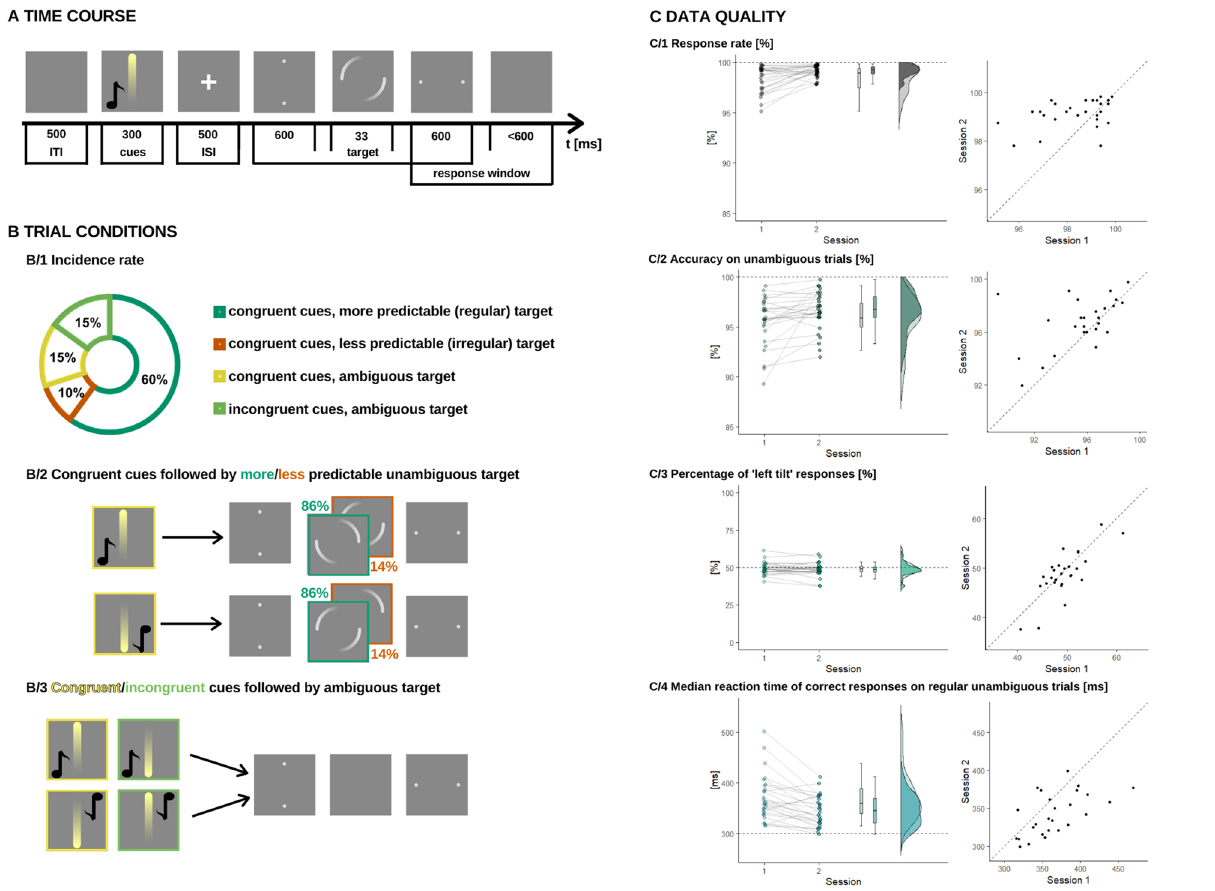
Figure 1. Experimental paradigm and data quality. ( A ) Time course. At the beginning of every trial, a multimodal cue pair was presented for 300 ms consisting of a yellow dot moving up or down and a higher or lower tone. This was followed by a 500 ms interstimulus interval, during which a fixation cross attracted attention to the middle of the screen. Then we presented dot pairs in vertical, then in horizontal position for 600–600 ms. Between these for 33 ms a motion strike indicated a turning illusion, disambiguating the stimuli, or on ambiguous trials we showed nothing (just the gray background), keeping the stimuli bistable. Participants were asked to indicate the perceived direction of the motion, their button presses were detected in the time interval from the presentation of the horizontal dotpair, until maximum 1200 ms later. We used a 500 ms long intertrial interval. ( B ) Trial conditions. Throughout the experiment 30% of the trials were ambiguous (no motion illusion presented). The cues presented were congruent (high tone + top-down movement, low tone + bottom-up movement) when preceding the unambiguous stimuli, and on half of the ambiguous trials. On the other half of the ambiguous trials the cues were incongruent (low tone + top-down movement, high tone + bottom-up movement). Congruent and incongruent cue-pairs remained the same throughout the experiment and across sessions. Trial conditions were balanced in every block of 40 trials. In-block trial order was randomized. In 8 blocks the underlying rule associated 1–1 congruent cuepair with 1–1 (more predictable) direction (0.6 = P(left | high tone, top-down move) = P(right | low tone, bottom-up move) > P(left | low tone, bottom-up move) = P(right | high tone, top-down move) = 0.1), in the other 8 to the other (0.6 = P(right | high tone, top-down move) = P(left | low tone, bottom-up move) > P(right | low tone, bottom-up move) = P(left | high tone, top-down move) = 0.1). These blocks followed each other in random order. ( C ) Data quality. Within each panel of the figure, on the left side, dots represent participants, and the values from each session are connected along the x axis, a boxplot (median, 50% CI) is shown, and the distribution for each session can be seen. While on the right side of the panels, each dot represents a participant’s performance in session 1 and 2 on the x and the y axis, respectively. Dashed line indicates the hypothetical perfect correlation. Please find test–retest statistics in Table 1. [C/1] Overall response rate was very high. Percentage of valid responses on 640 trials is presented. Test–retest stability was low, probably due to a ceiling effect. [C/2] Accuracy on unambiguous trials was very high. Percentage of correct answers on 448 unambiguous trials is shown. Test–retest stability was weak, which might be due to ceiling performance. [C/3] There was no general response tendency in the data. Percentage of ‘left tilt’ responses on 640 trials is shown. Test–retest stability was high. [C/4] Processing speed. Median RT of correct responses on 384 regular unambiguous trials. Test–retest stability was high and motor learning was